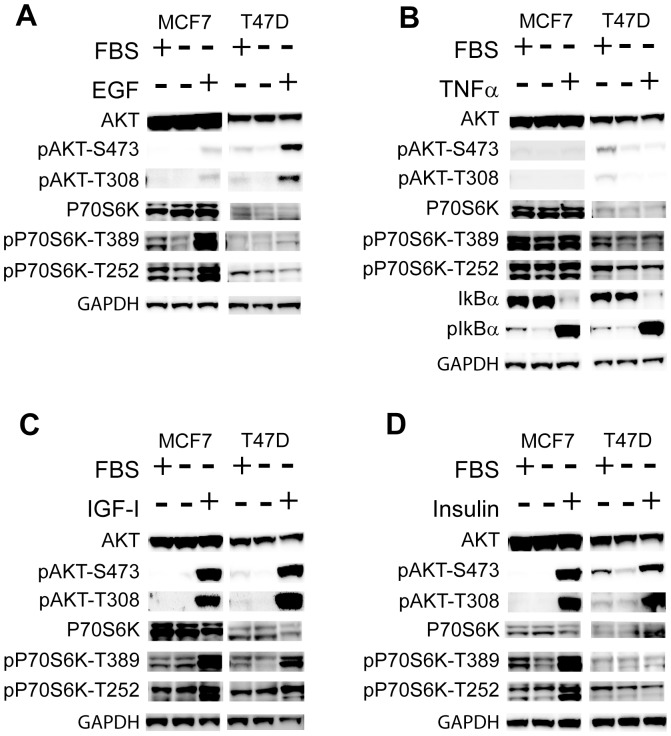
IGF-I stimulated PDK1 activity in MCF7 and T47D cells.Breast cancer cell lines MCF7 and T47D were cultured in normal growth media (supplemented with 10% FBS) or serum starved for 24 hours. Growth factors EGF (A), TNFα (B), IGF-I (C), or insulin (D) were added to the culture media for 15 minutes after starvation. Cells were subsequently harvested and lysed, and lysates were subjected to SDS-PAGE. Western blot analysis was performed to examine the phosphorylation levels of AKT and p70S6K. GAPDH was included in each western blot analysis as a protein loading control.